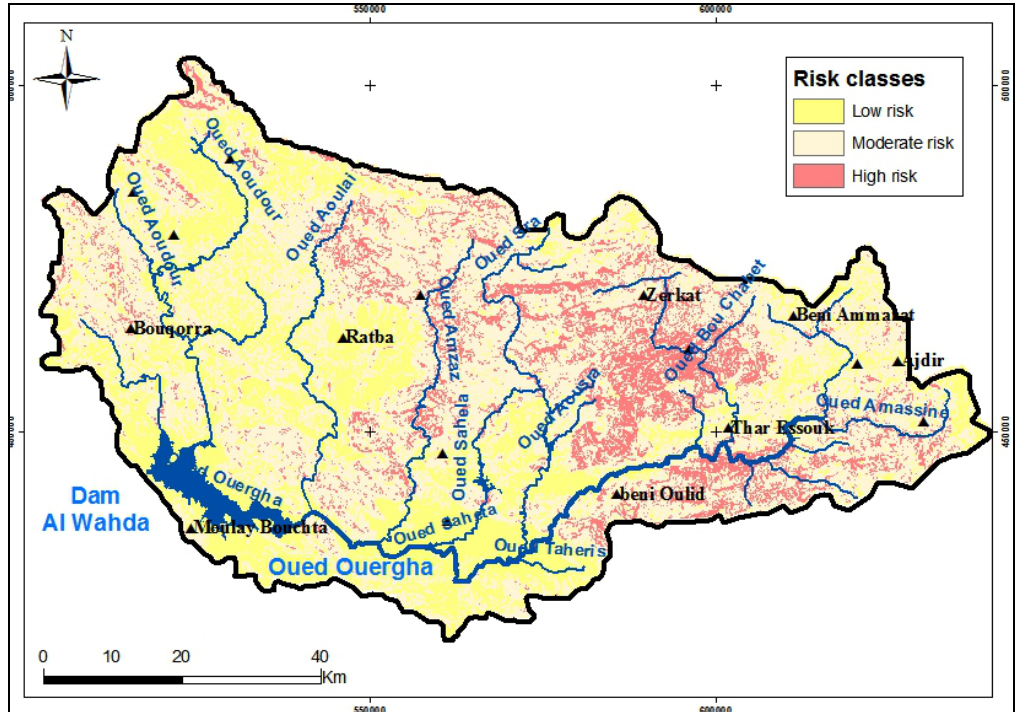
Figure 10 . Erosion Risk Management Decision